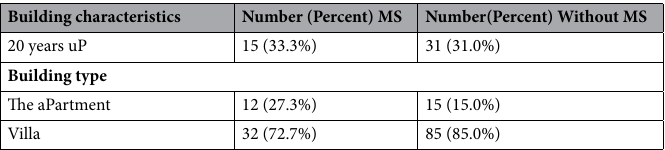
Table 2. Details of the residential house of the participants.